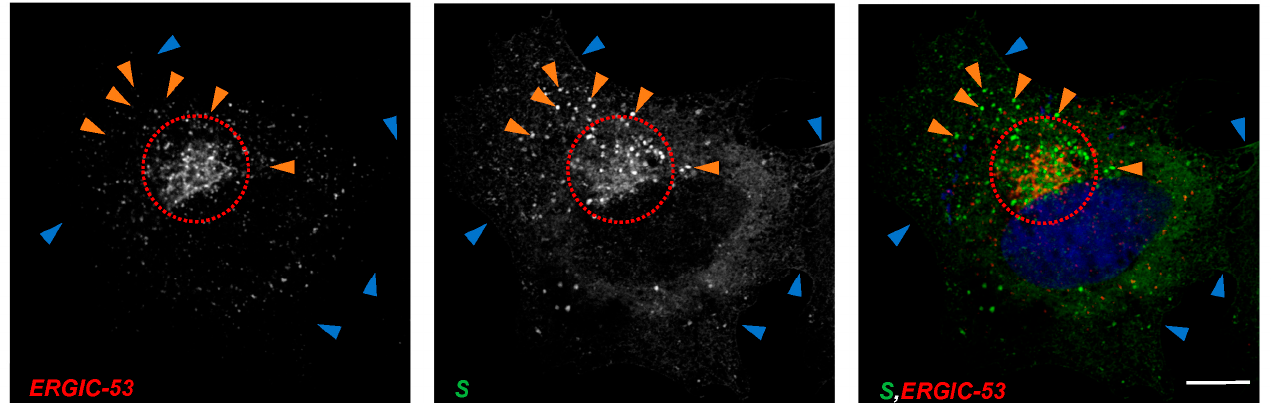
Figure 1. SARS-CoV-2 S colocalizes with ERGIC-53 in HuH7 cells. Subconfluent HuH7 cells were transfected with 500 ng pCAGGS-S and fixed after 24 h. Scale bars indicate 10 µ m. Subcellular distribution of the S protein in HuH7 cells was stained for S protein (green), endogenous ERGIC-53 (red) and nuclei (blue) with DAPI. (i) Encircled areas mark perinuclear accumulation, (ii) orange arrows demonstrate vesicle-like structures and (iii) blue arrows mark localization at the plasma membrane. Encircled area highlights the region of colocalization. Single staining of S can be found in Figure S4A. Data are representative of three independent experiments.